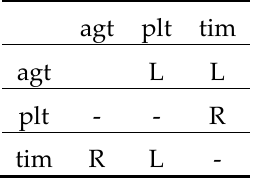
Figure 9. Precedence matrix for the UNL relation ‘agt’, ‘plt’, and ‘tim’.